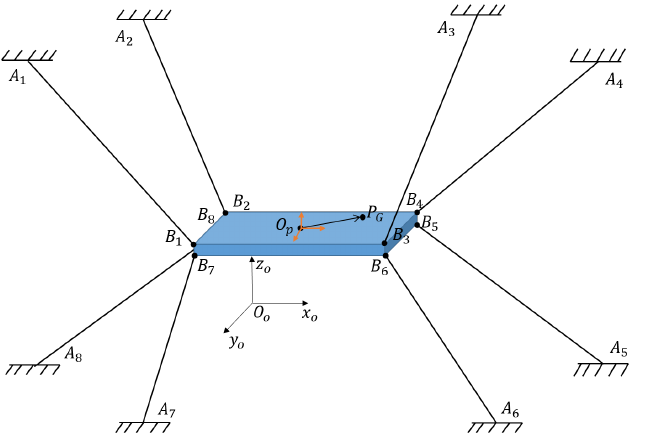
Figure 3. Cable-driven parallel robot with six degrees of freedom and eight